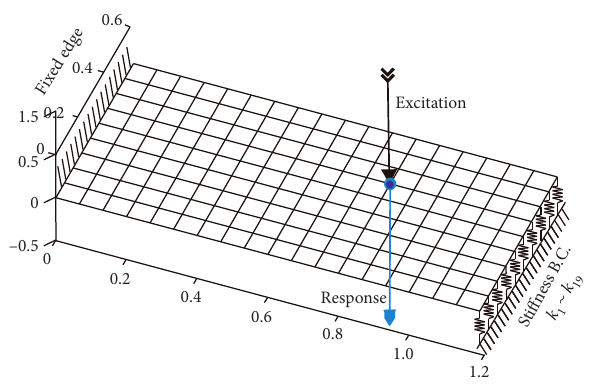
Figure 1: Schematic of FEM modeling of the rectangular plate. Table 1: Parameters and random boundary conditions of the rectangular